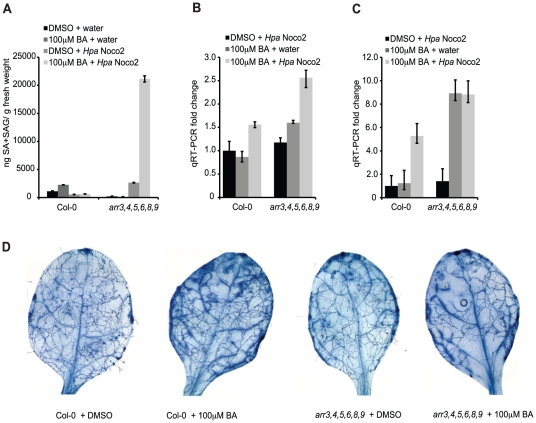
Type-A ARRs act in plant immunity downstream of SA.(A) Total SA production in response to Hpa Noco2 after cytokinin treatment. Two-week-old wild-type and arr3,4,5,6,8,9 plants were pre-treated with the indicated concentration of BA or DMSO control 48 hours prior to inoculation with water or Hpa Noco2. Tissue was harvested at 3 dpi and total SA (SA+SAG) measured as described in Methods. Error bars represent SE (n≥4). The experiment was repeated at least three times independently. Data from one representative experiment are shown. (B) ICS1 expression in response to Hpa Noco2 after cytokinin treatment. Two-week-old wild-type and arr3,4,5,6,8,9 plants were treated as in (A). Tissue was harvested at 3 dpi. Levels of ICS1 were determined by qRT-PCR relative to water-treated samples pre-treated with DMSO. For simplicity, the relative change of all samples was normalized to the wild-type DMSO+Hpa Noco2 levels. Error bars represent SE from three technical replicates and correspond to upper and lower limits of 95% confidence intervals. The experiment was repeated at least three times independently. Data from one representative experiment are shown. (C) PR1 expression in response to Hpa Noco2 after cytokinin treatment. Two-week-old wild-type and arr3,4,5,6,8,9 plants were treated as in (A). Tissue was harvested at 3 dpi. Levels of PR1 were determined by qRT-PCR relative to water-treated samples pre-treated with DMSO. For simplicity, the relative change for all samples was normalized to the wild-type DMSO+Hpa Noco2 levels. Error bars represent SE from three technical replicates and correspond to upper and lower limits of 95% confidence intervals. The experiment was repeated at least three times independently. Data from one representative experiment are shown. (D) Trypan blue staining after Hpa Noco2 inoculation. Two-week-old wild-type and arr3,4,5,6,8,9 plants were treated as in (A). Plants were harvested at 4 dpi and stained with lacto-phenol trypan blue to visualize pathogen structures.